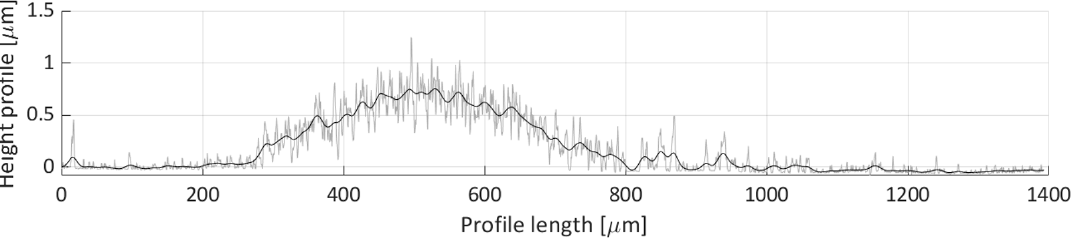
Figure 21. Height profile for the H1 line.